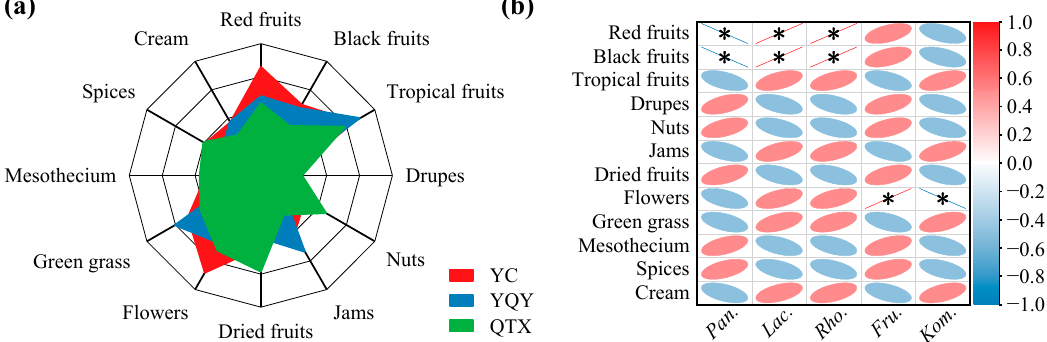
Figure 8. Correlation analysis between core bacteria and aroma profiles. ( a ) Aroma profile of spontaneously fermented grape wines from three sub-regions analyzed by QDA. ( b ) A correlation heatmap was used to identify significant linear correlations between each aroma descriptor and each core bacterial genus. A red ellipse with an asterisk represents a significantly positive correlation (Spearman’s rank test, p < 0.05), while a blue ellipse with an asterisk represents a significantly negative correlation (Spearman’s rank test, p < 0.05). Pan. , Pantoea ; Lac. , Lactobacillus ; Rho. , Rhodococcus ; Fru. , Fructobacillus ; Kom. , Komagataeibacter.